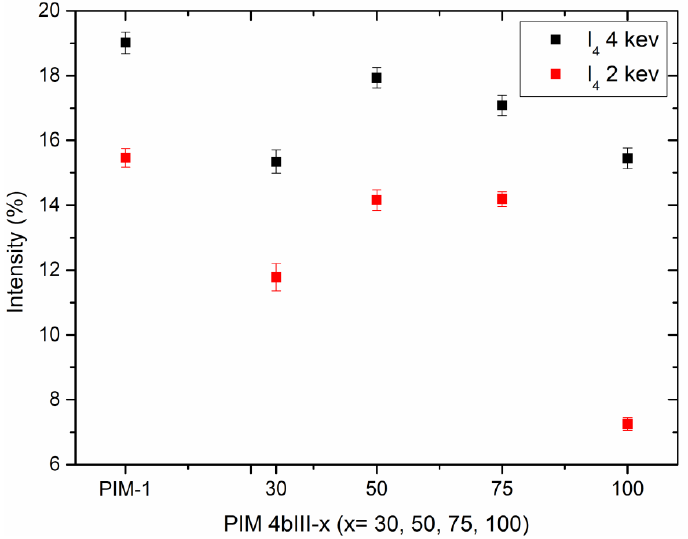
Figure 6. o-Ps intensities corresponding to o-Ps lifetimes in Figure 5 as a function of polymer variants